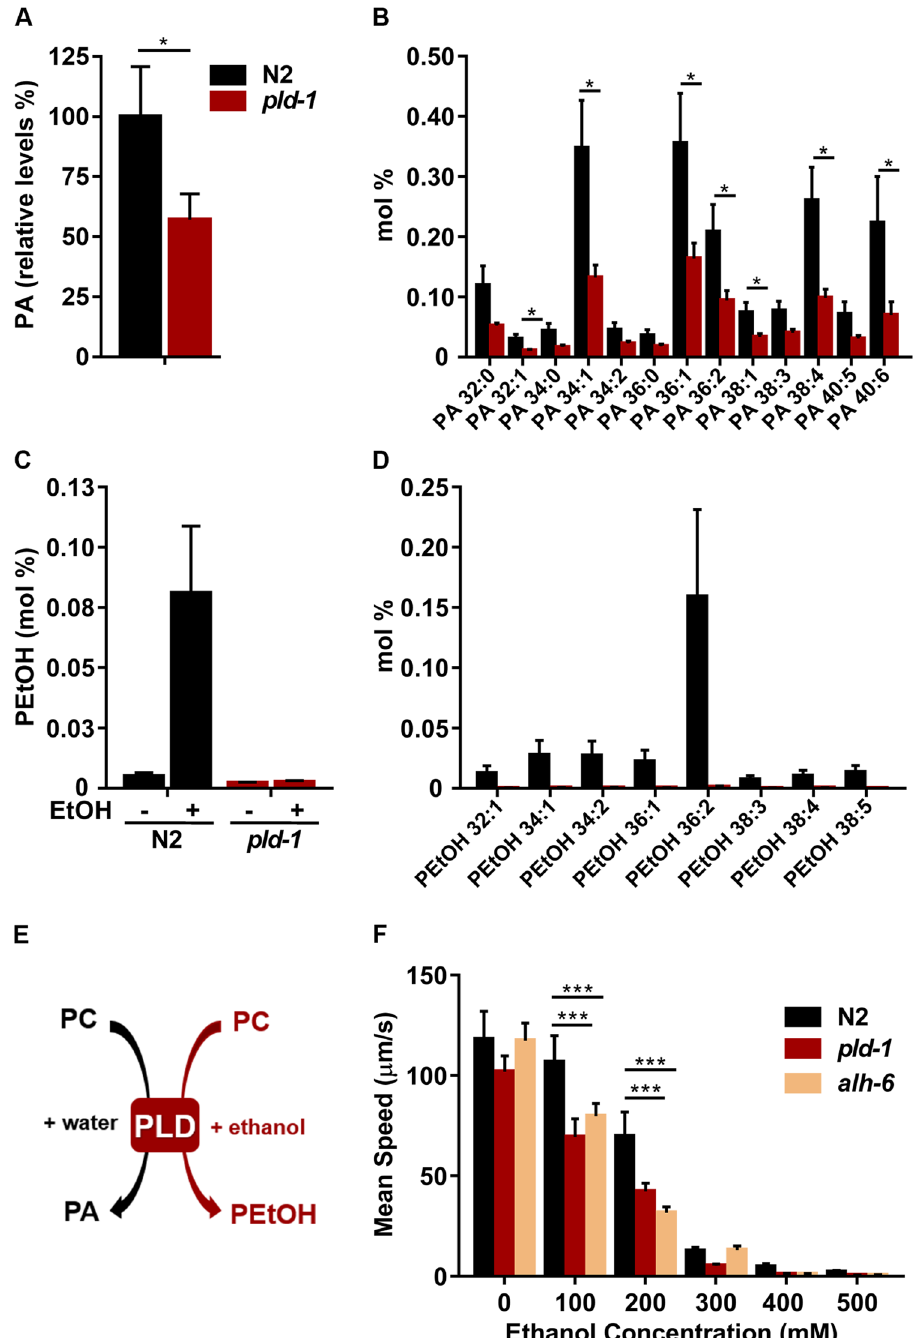
Figure 1. pld-1 animals show decreased PA levels and PLD activity. ( A ) pld-1 ablation causes a 50% reduction on total phosphatidic acid (PA) relative levels in C . elegans . ( B ) Relative amounts of the different PA species measured in pld-1 and WT animals. Levels of PA were quantified by Liquid Chromatography Mass Spectrometry (LC-MS) analysis (n = 6). ( C ) Relative amounts of total PEtOH ( D ) and of the different PEtOH species measured in pld-1 and WT animals (n = 6) and quantified by LC-MS. ( E ) Graphical representation of the synthesis reaction of phosphatidylethanol (PEtOH) in vivo . PLD has an increased affinity to primary alcohols, leading to the generation of PA in the presence of water, or PEtOH if in the presence of ethanol. This reaction is the only source of PEtOH and can be used as a measure of PLD activity. ( F ) pld-1 animals are more susceptible than WT to the acute effects of ethanol (at 100 and 200 mM), similarly to the ethanol-susceptible strain alh-6 , as shown by the decrease in the mean speed of the animals (n = 6). Values denote mean ± SEM ( * p < 0.05, *** p < 0.001). The nomenclature for PA and PEtOH fatty acid species composition is expressed as total chain length: number of unsaturated